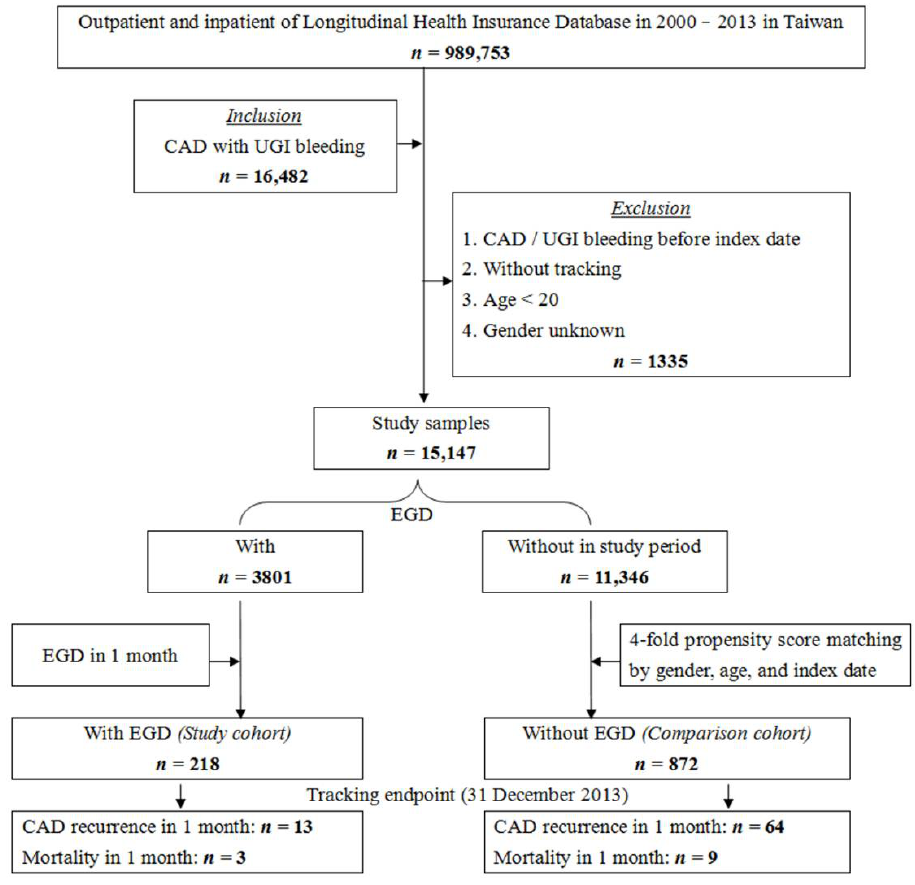
Figure 1. Flowchart of the study. The abbreviations: coronary artery disease (CAD); esophagogastroduodenoscopy (EGD); upper gastrointestinal (UGI).